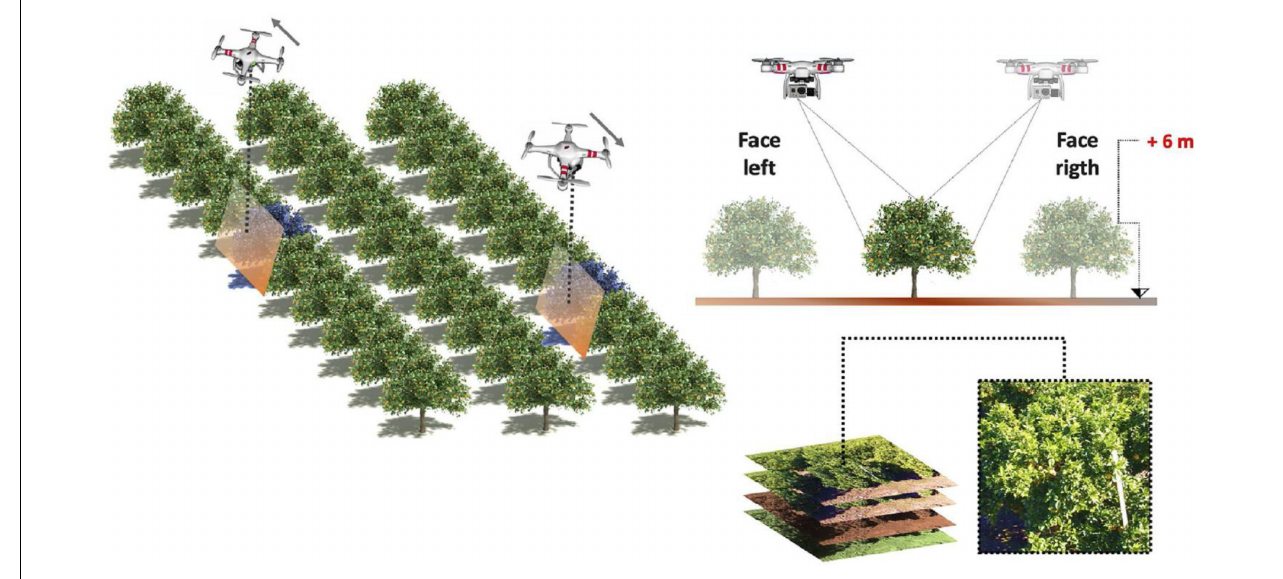
FIGURE 12 | Workflow of field tests (Apolo-Apolo et al.,